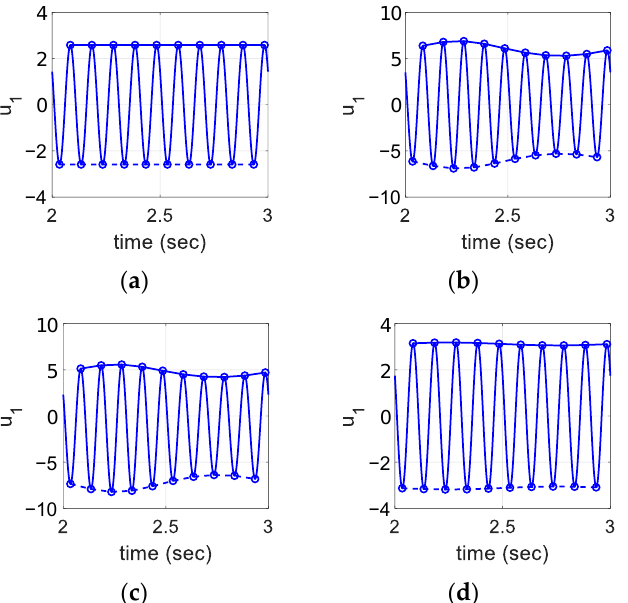
Figure 14. Control signals ( 𝑢 1 ): ( a ) Normal, ( b ) the zero output mode, ( c ) the fixed output mode, ( d ) the scaled-down mode.